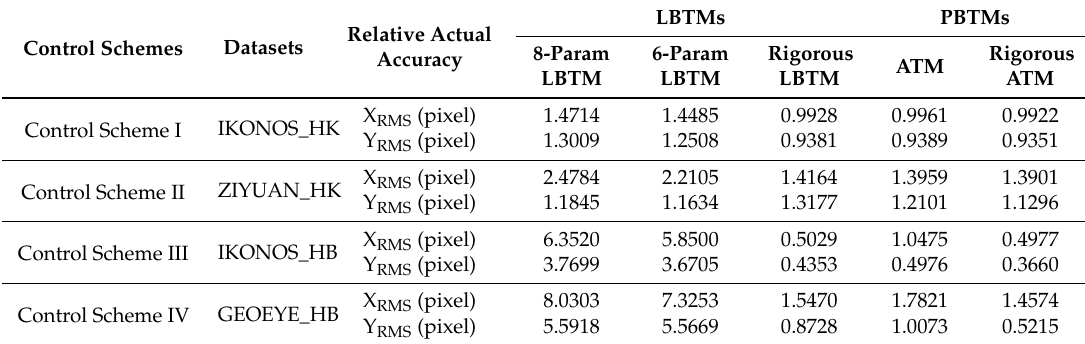
Table 3. Relative actual accuracies of Control Schemes I to IV by different LBTMs and PBTMs. Param, Parameter; ATM, Affine Transformation